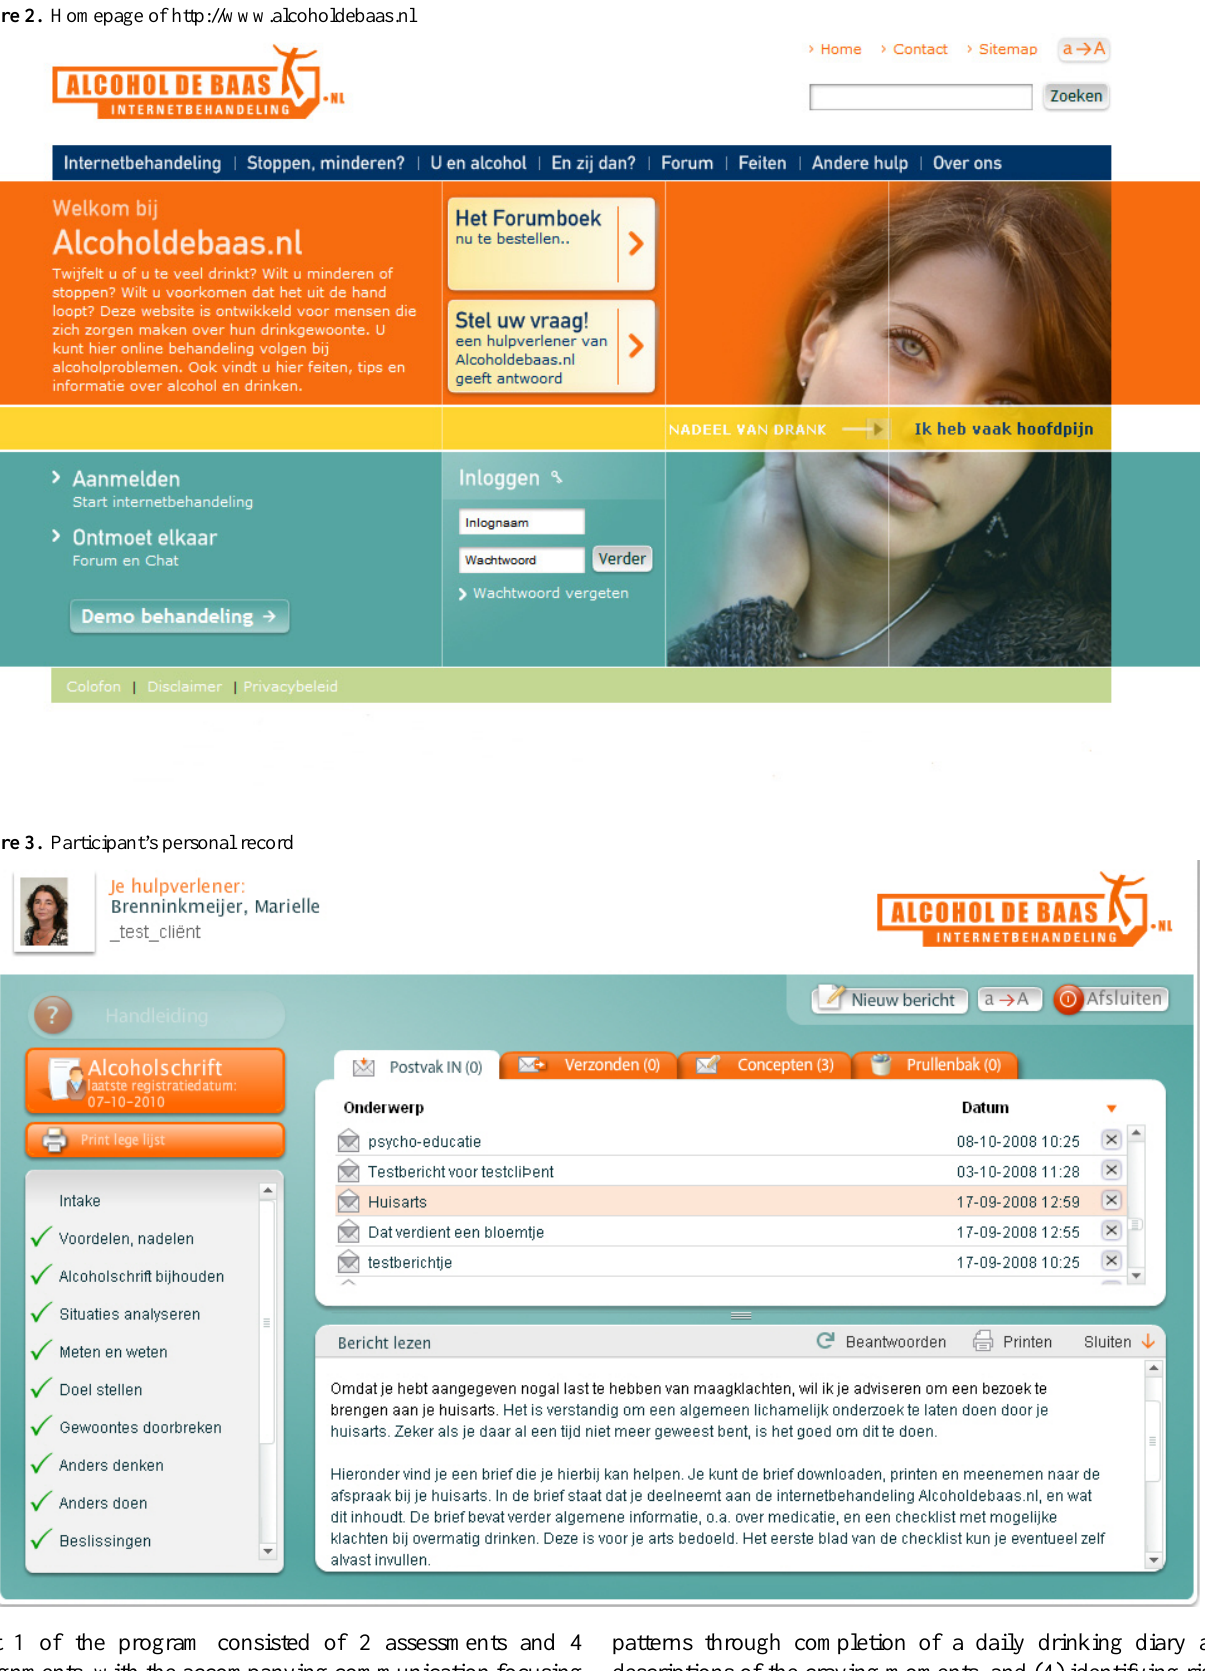
Figure 2. Homepage of http://www.alcoholdebaas.nl